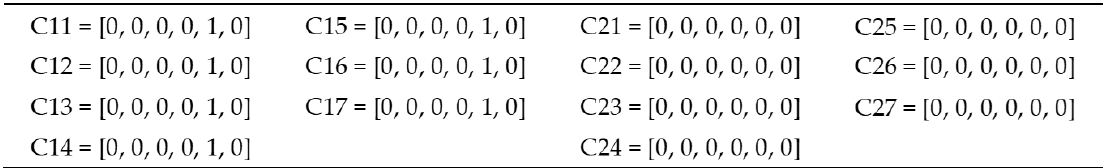
Figure 7. An example of data type and text feature vectors.